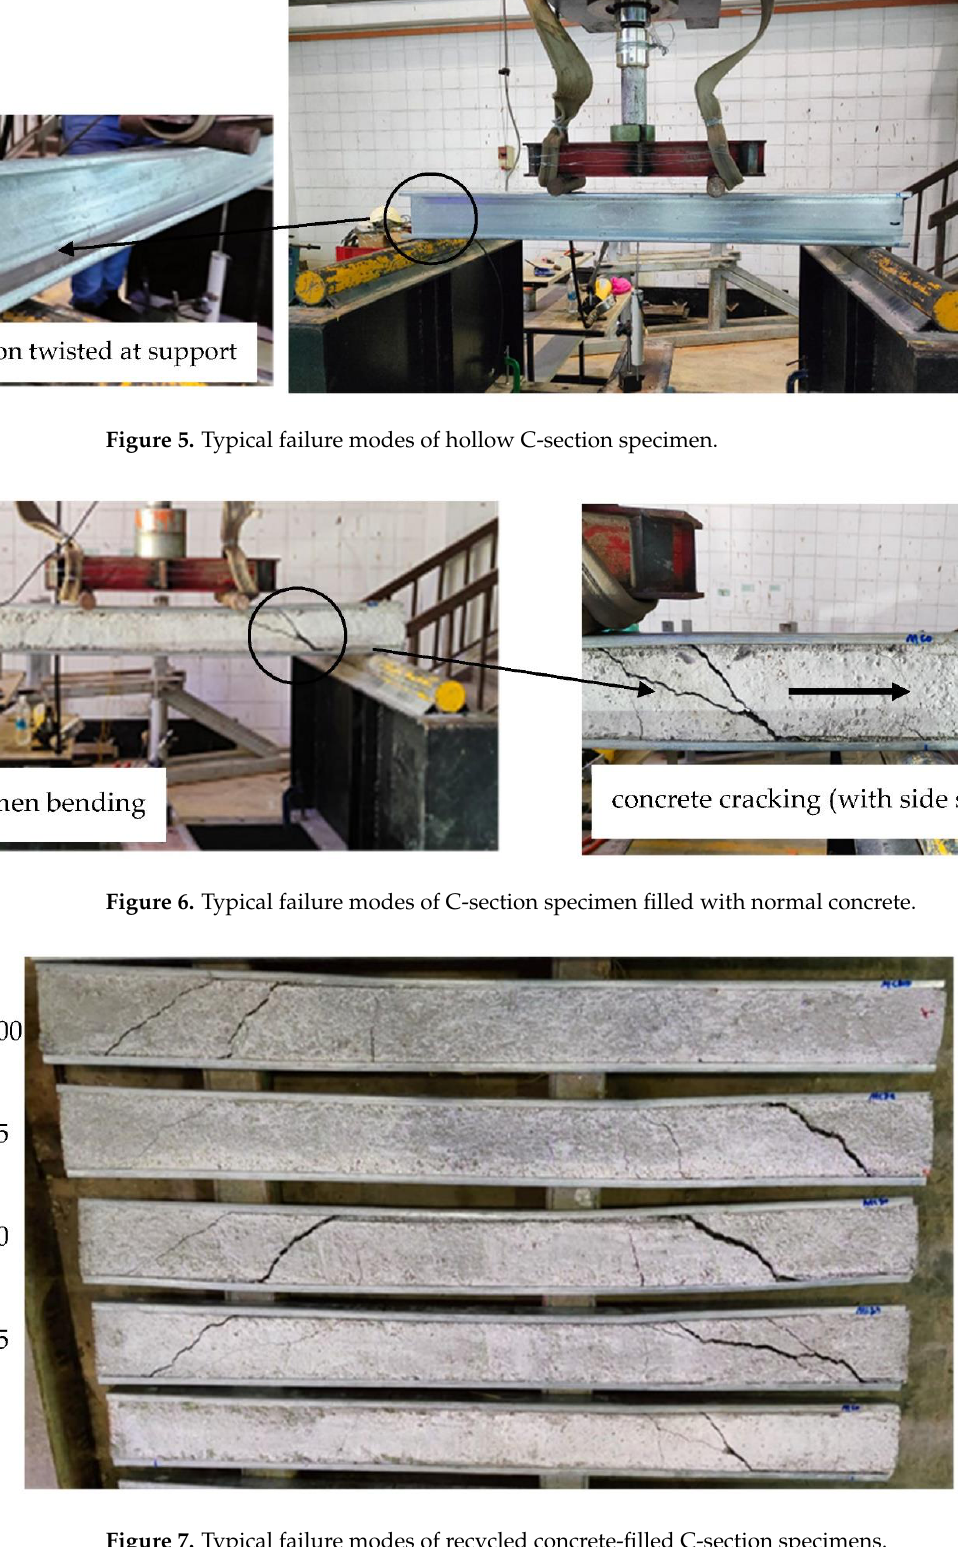
Figure 7. Typical failure modes of recycled concrete-filled C-section